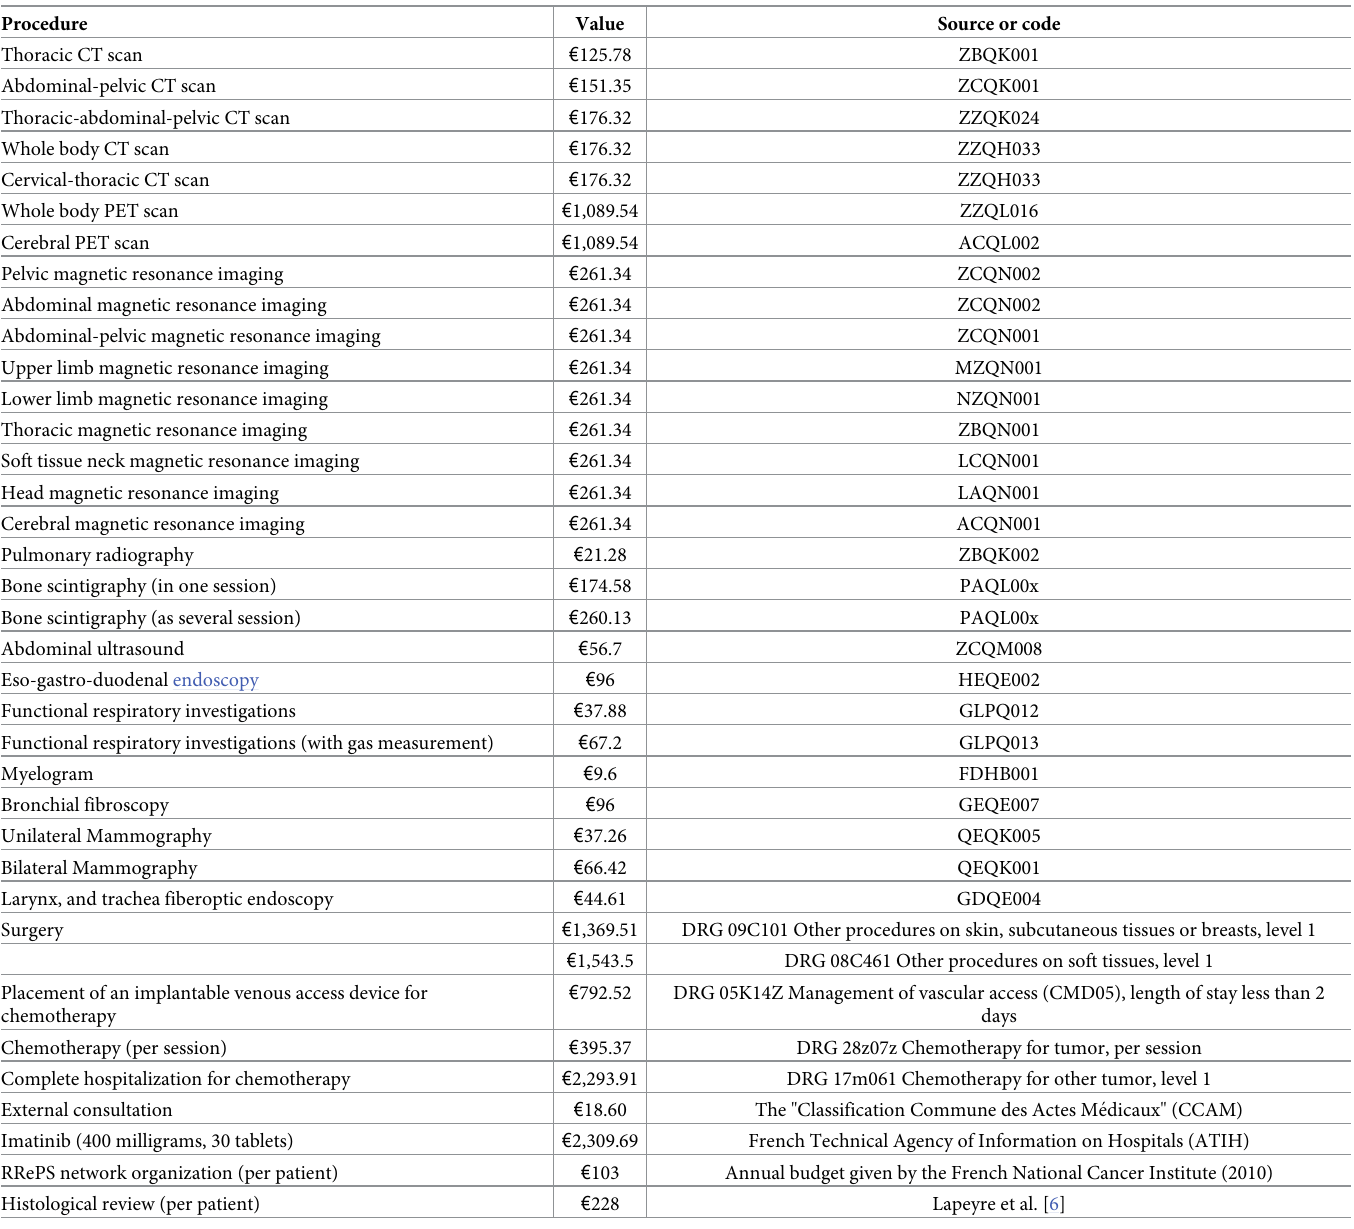
Table 6. Main unitary costs and prices (in € for